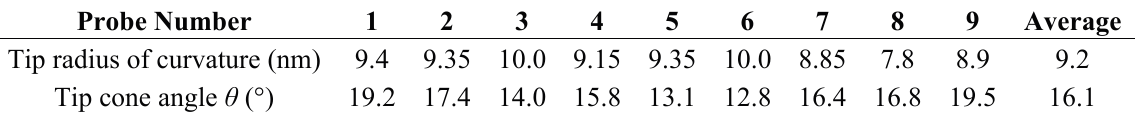
Table 1. The parameters of nine unused probes (CSG01) obtained from SEM